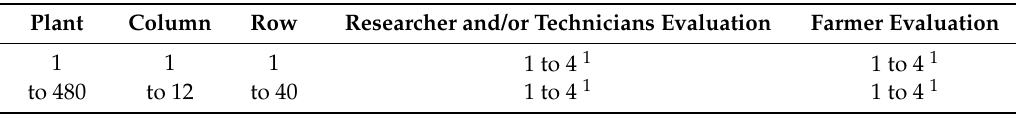
Table 5. Evaluation of a single plant (three to five researchers and/or technicians and three to five farmers).